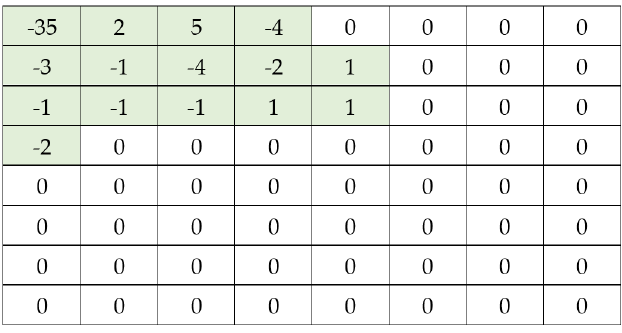
Figure 8. The JPEG coefficients.